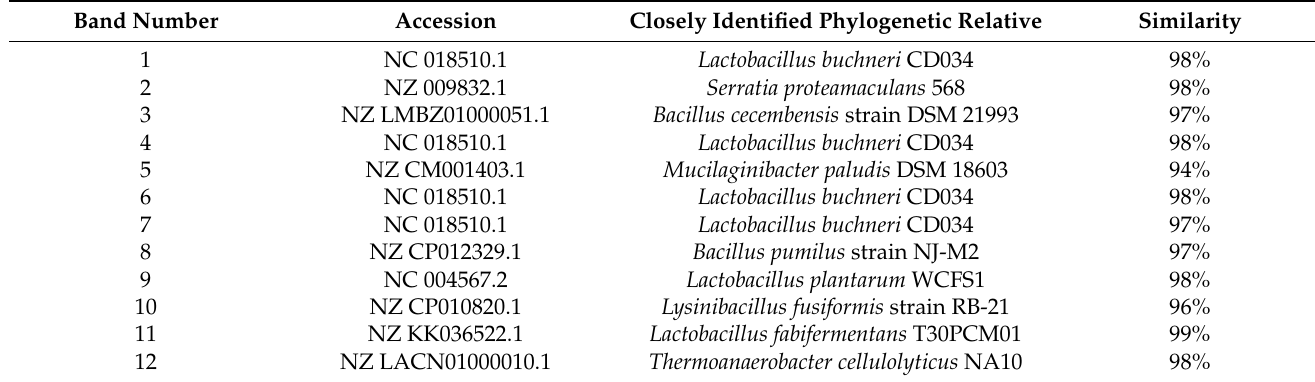
Table 6 . Effects of additives on the Shannon diversity index of DGGE profiles of Lolium multiflorum Lam. silage after 60 days of fermentation .